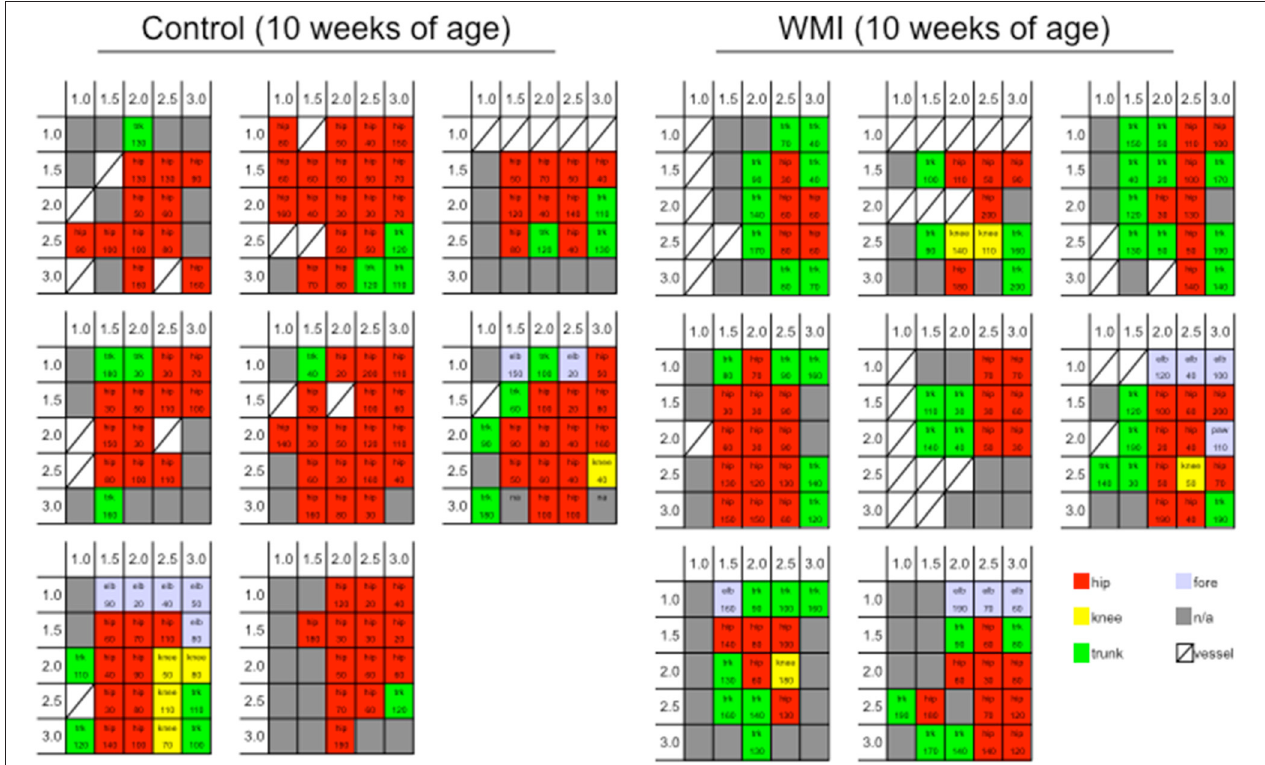
FIGURE 1 | Cortical motor map by ICMS at 10 weeks of age. We stimulated the sensorimotor cortex per 0.5mm at 1.0–3.0mm right and 1.0–3.0mm posterior from the bregma. Each grid shows a cortical map of each rat cortex in control group ( n = 8) and neonatal WMI group ( n = 8). Blocks in the grids show the portion of the rat body in which twitching was observed (hip joint, knee joint, trunk, and forelimb), and the current threshold is presented in each grid. Cortical maps are shown as a 5-colored code in the grid: twitching of the hip joint (red), knee joint (yellow), foot joint (light blue), and trunk (green), and non-responsive square